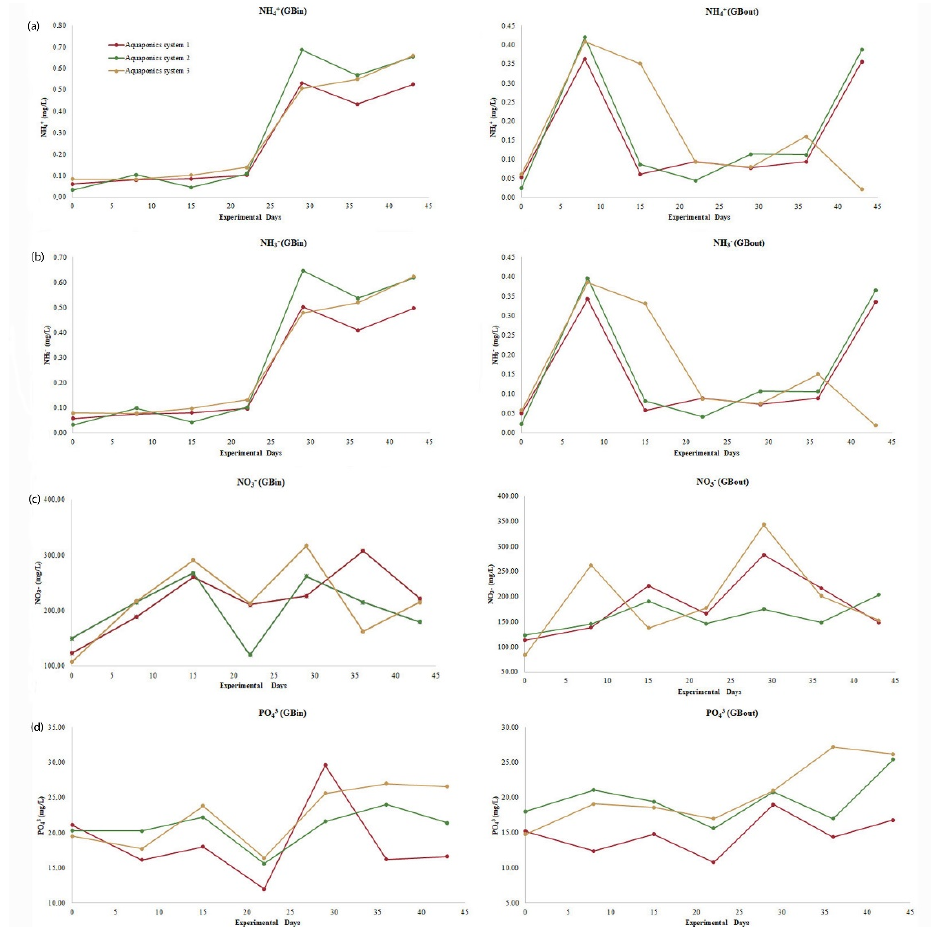
Figure 2. Concentrations of ( a ) ammonium, ( b ) un-ionized ammonia, ( c ) nitrate, and ( d ) phosphate at the water inlet point (GBin) and exit point (GBout) of the three aquaponic systems over the 45-day period.